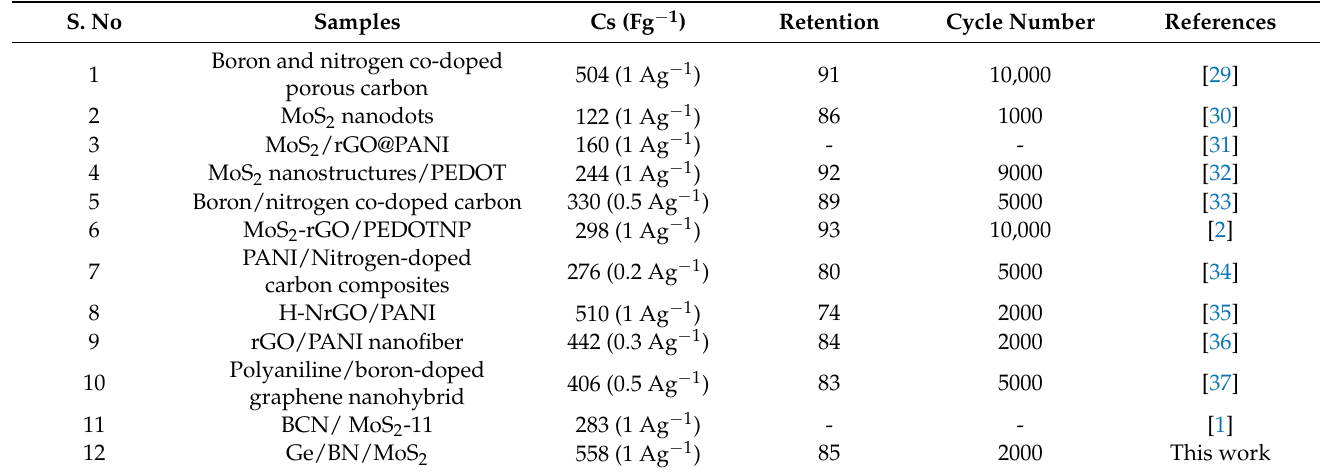
Table 1. Comparison of specific capacitance and capacitance